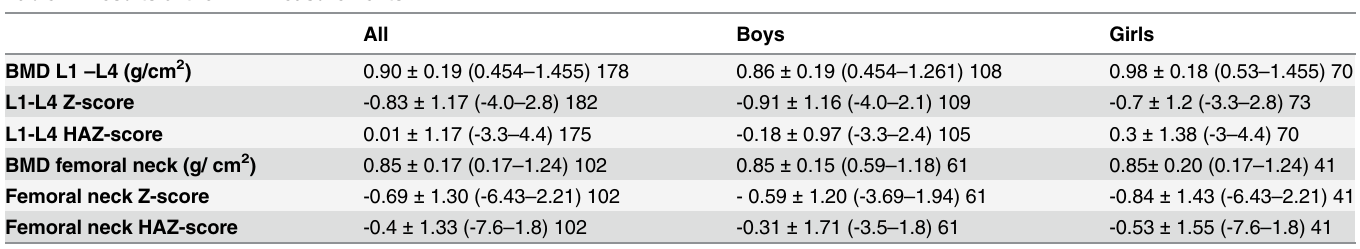
Table 2. Results of the DXA measurements.